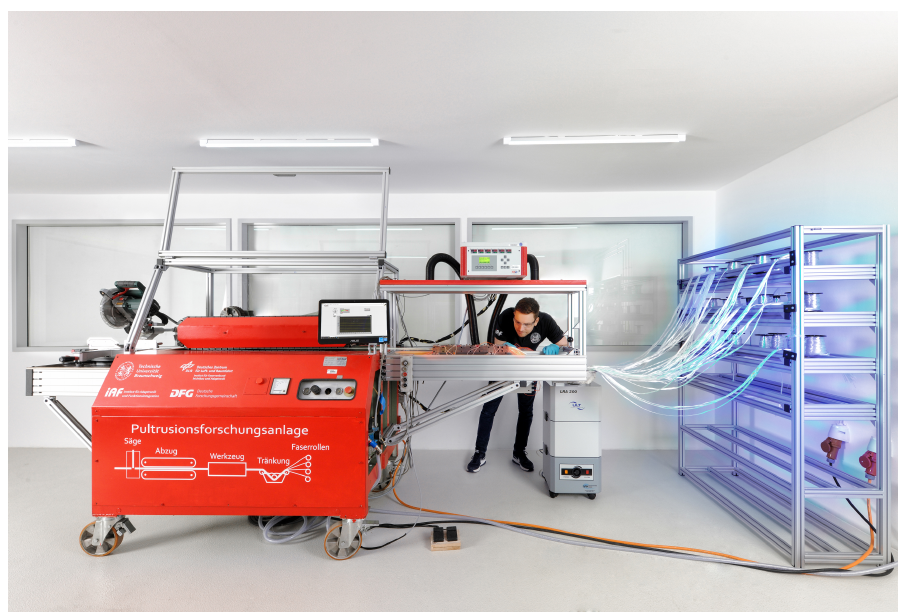
Figure 1. Laboratory pultrusion system.